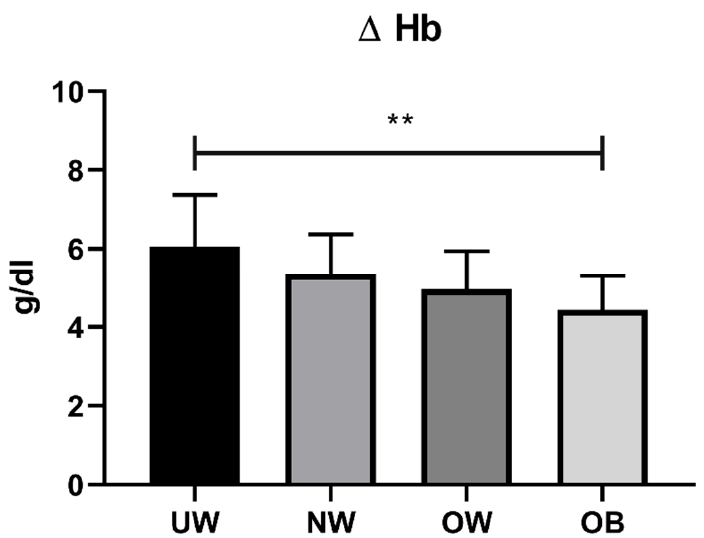
Figure 6. Hemoglobin loss in different BMI classes (UW, BMI% ≤ 5; NW, 5 < BMI% ≤ 84; OW, 84 < BMI% < 95; OB, BMI% ≥ 95). ** p < 0.01